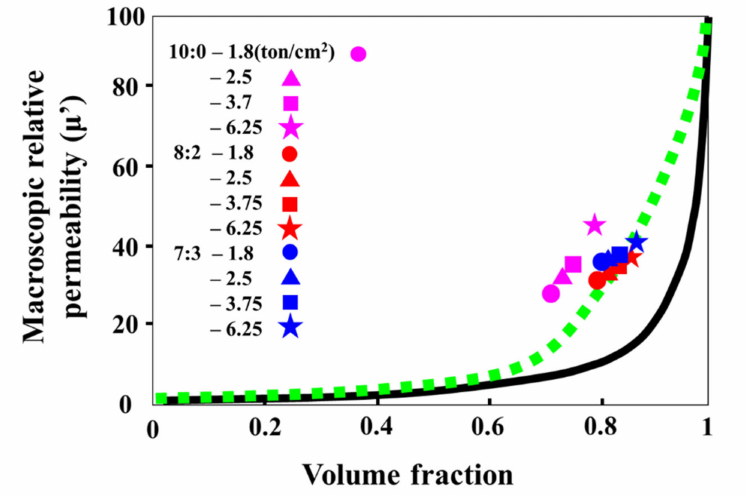
Figure 5. Volume fraction and permeability measurements, using Ollendorf’s theory for each magnetic bulk